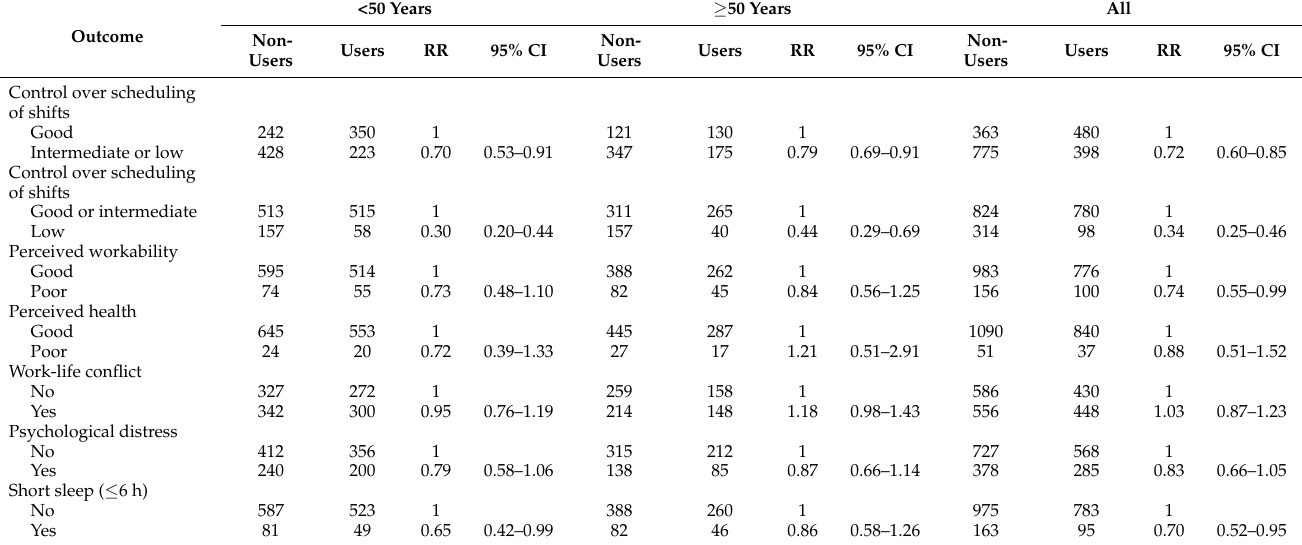
Table 4. Effects of using participatory working time scheduling software on the outcomes by age groups. RR, risk ratio.